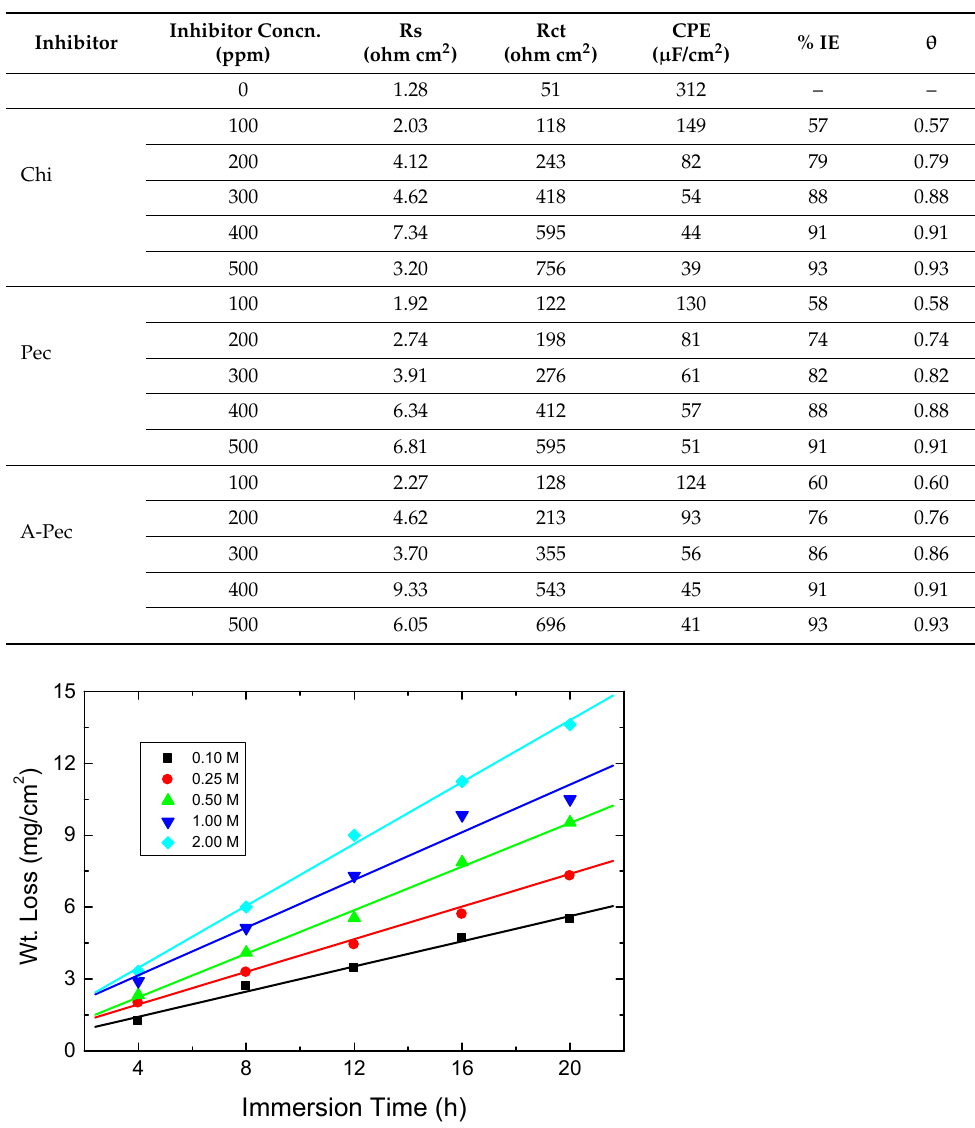
Figure 7. Electrochemical equivalent circuit utilized to fit the EIS output data for mild steel in 0.5 M HCl solution in absence and presence of the examined carbohydrate polymers. Table 2. Impedance parameters for mild-steel corrosion in 0.5 M HCl solution in absence and presence of the examined carbohydrate polymers at 303 K.